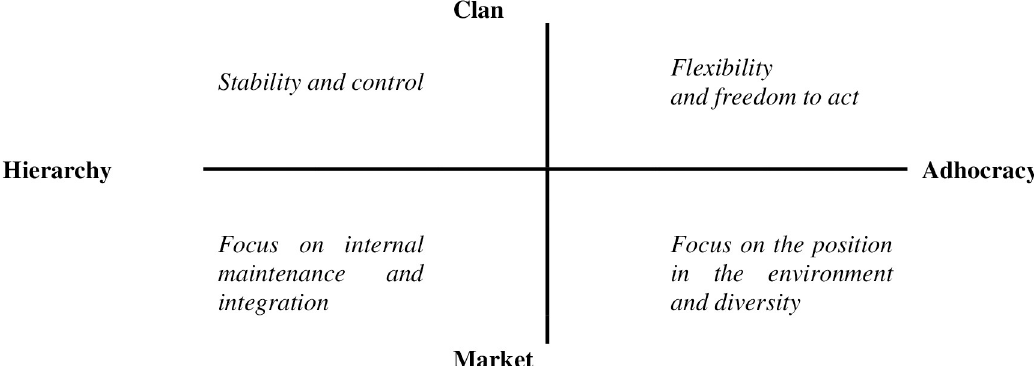
Fig 3. Cameron’s and Quinn’s organisational culture profile